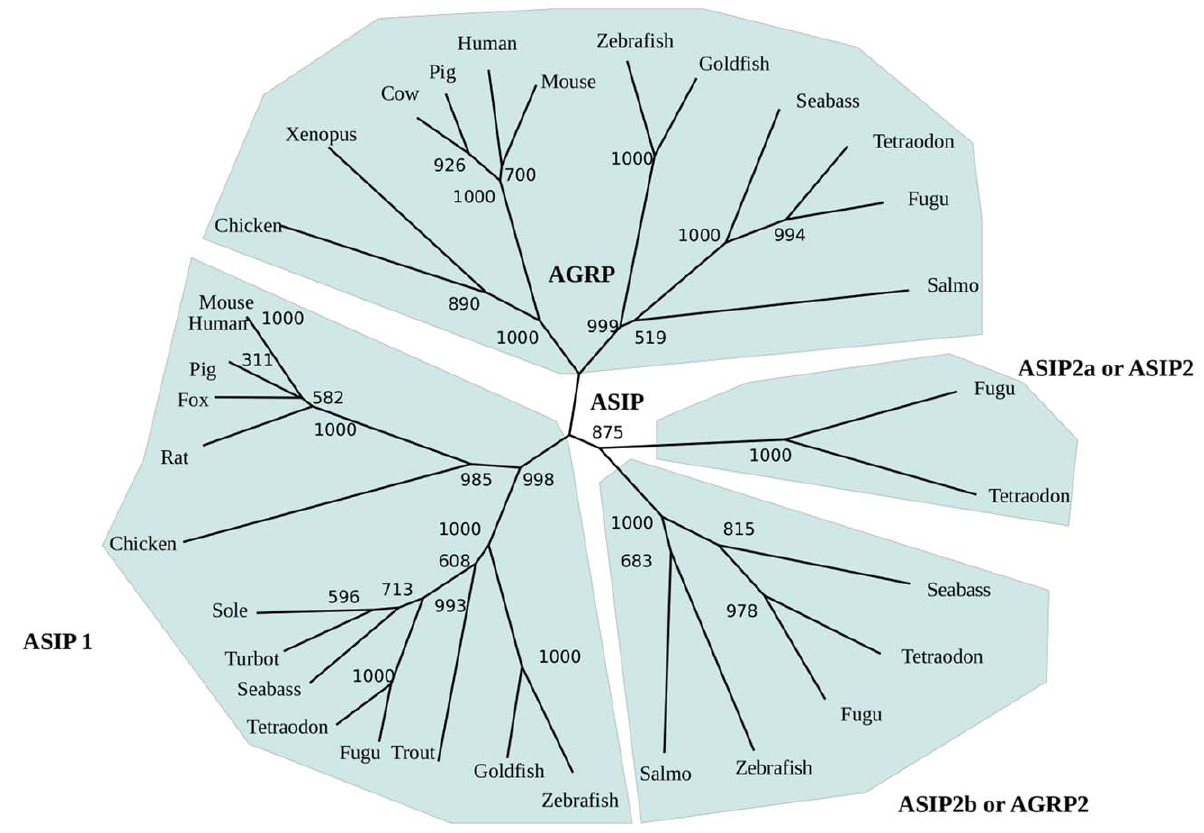
Figure 2. Phylogenetic tree of asip and agrp amino acid sequences built using CulstalX, which uses the Neighbor-Joining method on a matrix of distances. Numbers at branch nodes represent the confidence level of 1000 bootstrap replications. Phylogenetic analysis were done also by maximum likelihood using Seaview free software and no considerable differences were found.